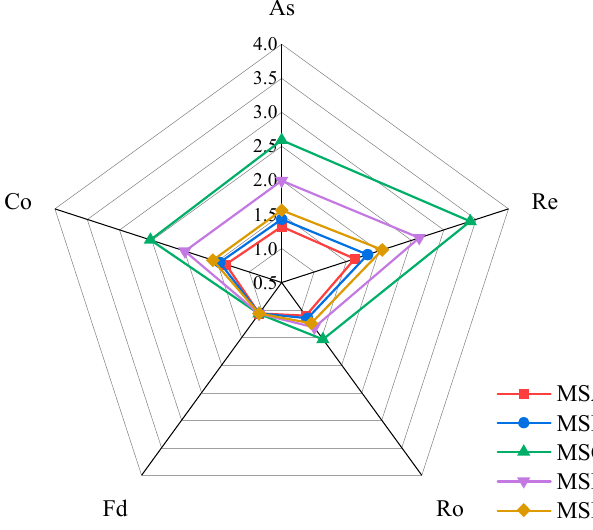
MF1 MF2 Figure 16. Slump of concrete with different manufactured sands.